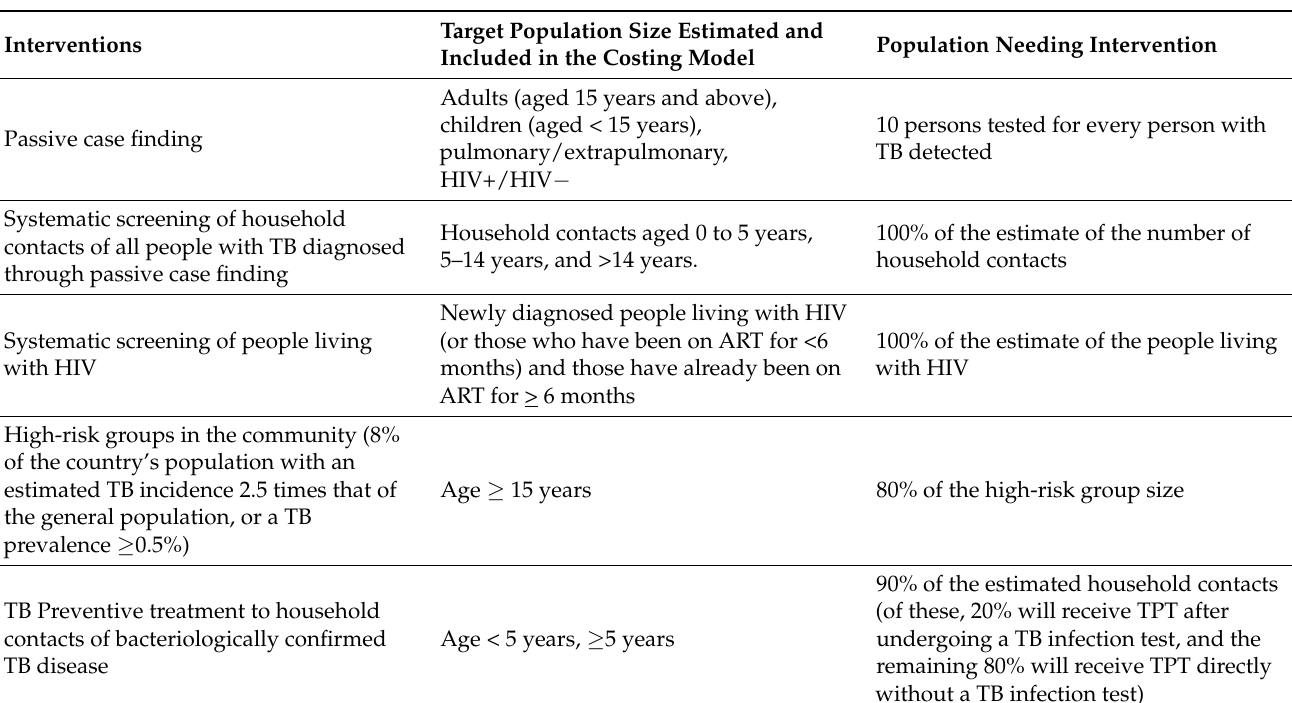
Table 4. Assumptions made to estimate the size of the target population requiring interventions and services to meet 2022 UNHLM targets for case detection and